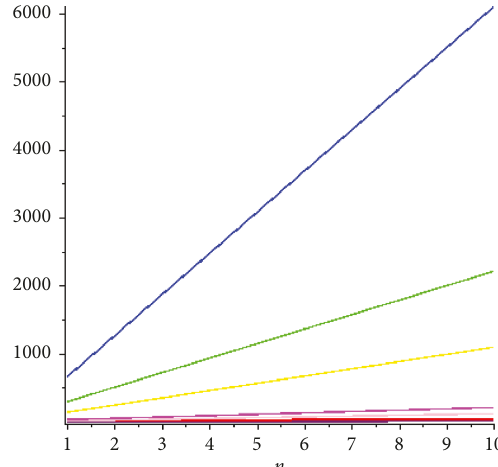
Figure 3: Graphical analysis of degree-based topological